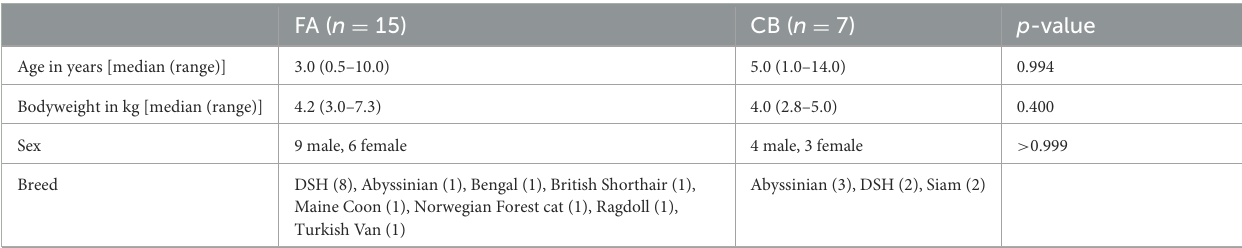
TABLE 1 Baseline parameters in cats with chronic bronchial